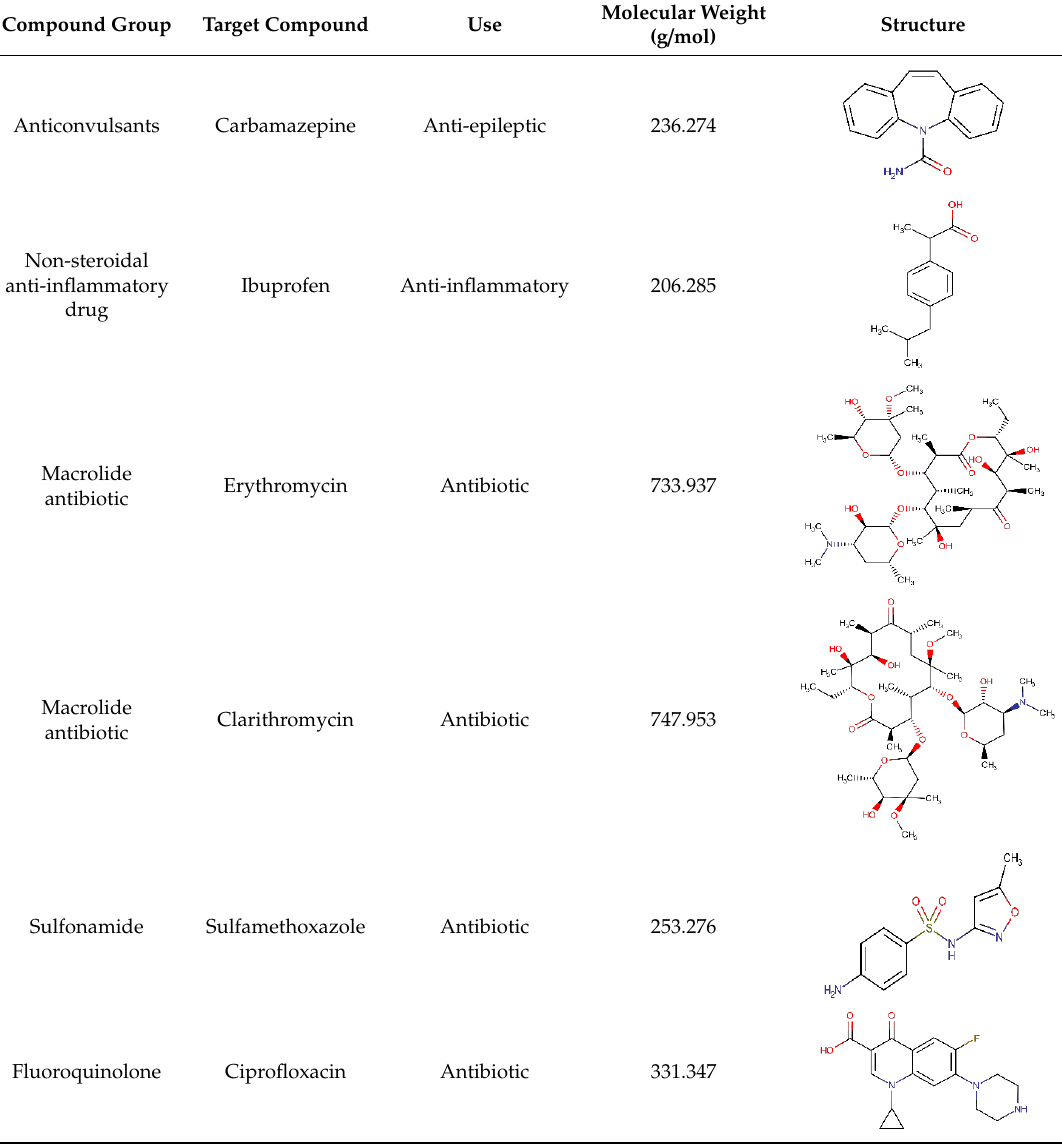
Table 2. List of target pharmaceutical compounds and their structures [48].